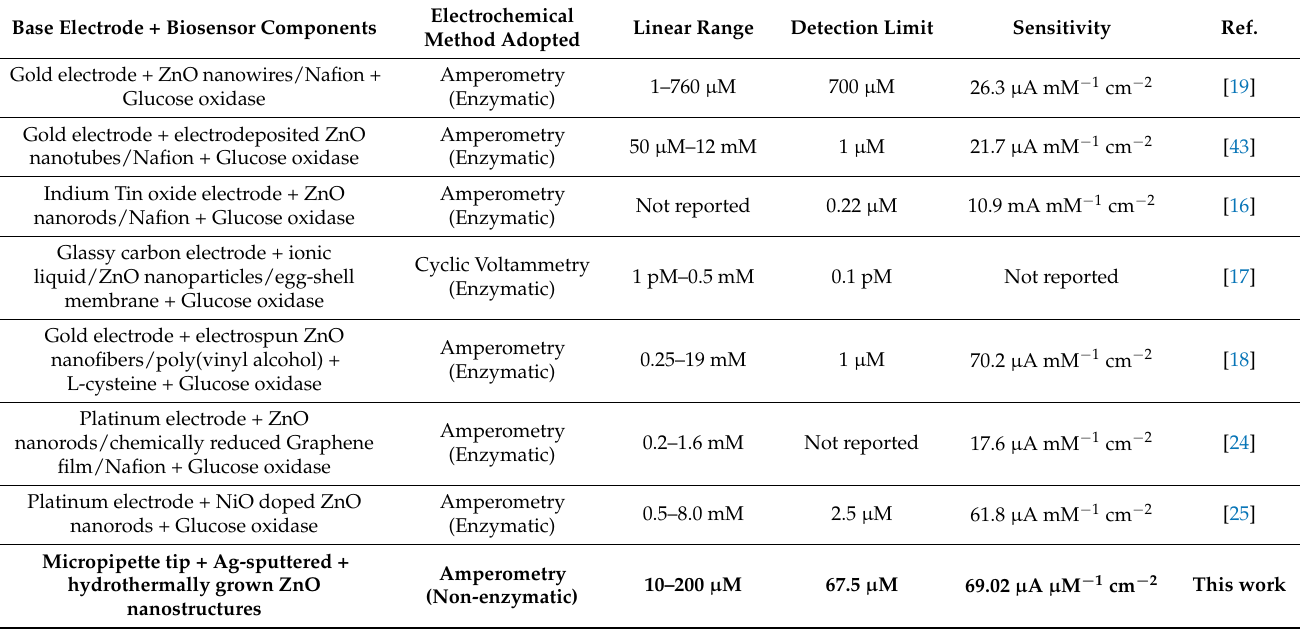
Table 2. Comparison of the present work with the available